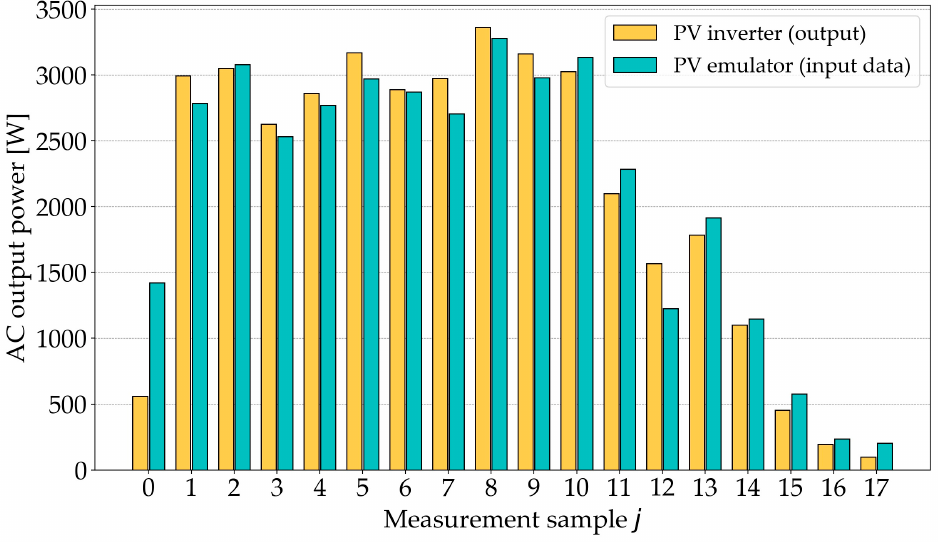
Figure 10. Comparison of AC output power of the 6 kW PV plant made of Masdar MPV100-S PV modules for 2 September 2018.